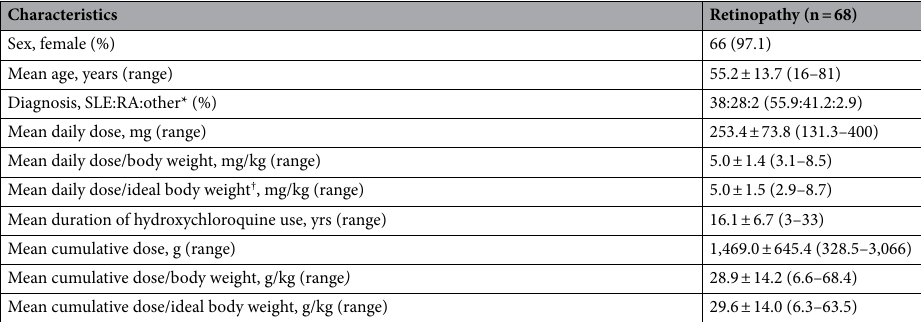
Table 1. Demographic data and clinical characteristics of the included patients screened for hydroxychloroquine retinopathy. RA Rheumatoid arthritis, SLE Systemic lupus erythematosus. *Other medical indications included mixed connective tissue disease and Sjögren’s syndrome. † Calculated by Devine formula (IBW = 50 + 2.3 kg per inch over 5 feet [for men] or 45.5 + 2.3 kg per inch over 5 feet [for